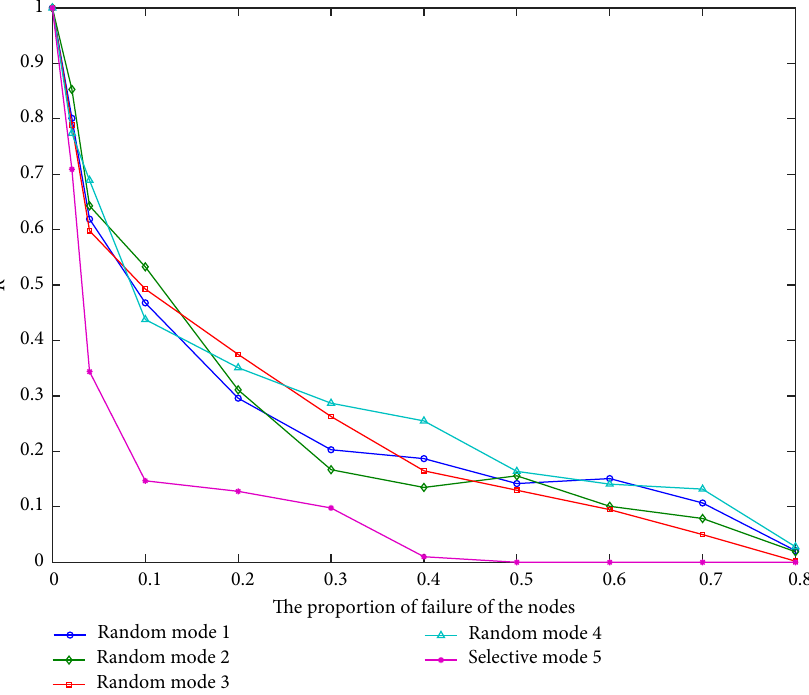
Figure 10: Distribution of 𝑅 under station failure